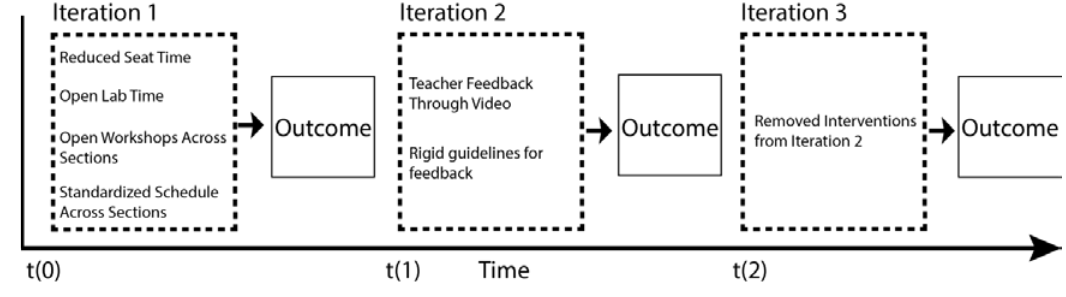
Figure 1. Visual representation of design research comparing iterations over time.